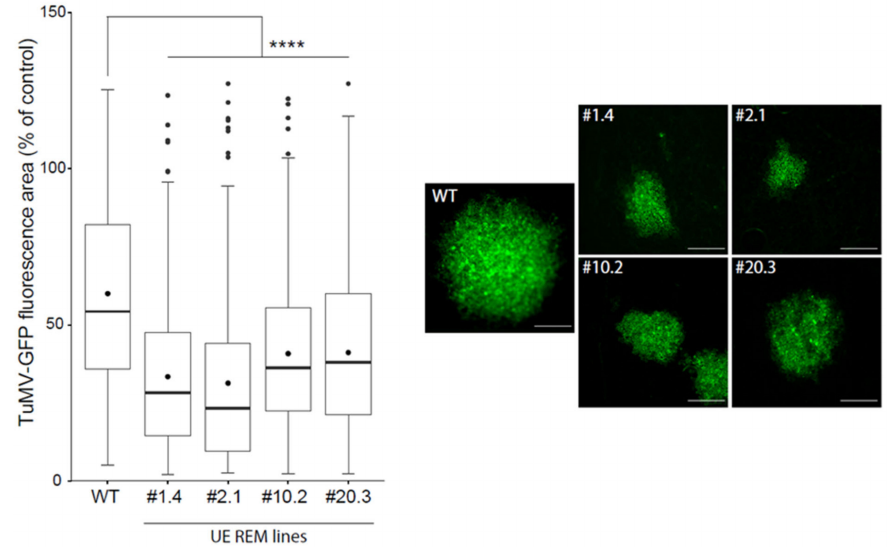
Figure 2. TuMV spreading is slowed down in four independent transgenic N. benthamiana lines un- derexpressing group 1 endogenous NbREMs (UE REM lines). The area of infection foci is normalised and expressed in % of the area of TuMV propagation in WT plants. GFP allowed the observation and measurement of infection surface foci induced by TuMV in the hairpin REM lines. At least 150 infection foci from at least 3 independent experiments were imaged at 5 days post-inoculation (dpi). Statistical analysis was performed using one-way ANOVA, followed by Student’s t -test in R software (ANOVA, p < 2.2 × 10 − 16 ; **** < 0.001). Scale bar: 500 µ m.